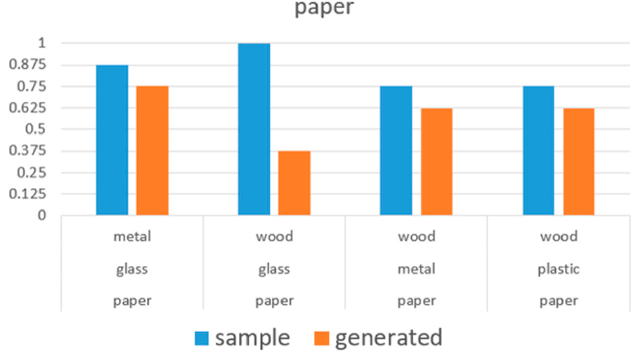
Figure 21. Accuracy of “paper” class in main (generated) and preliminary (sample) experiments.